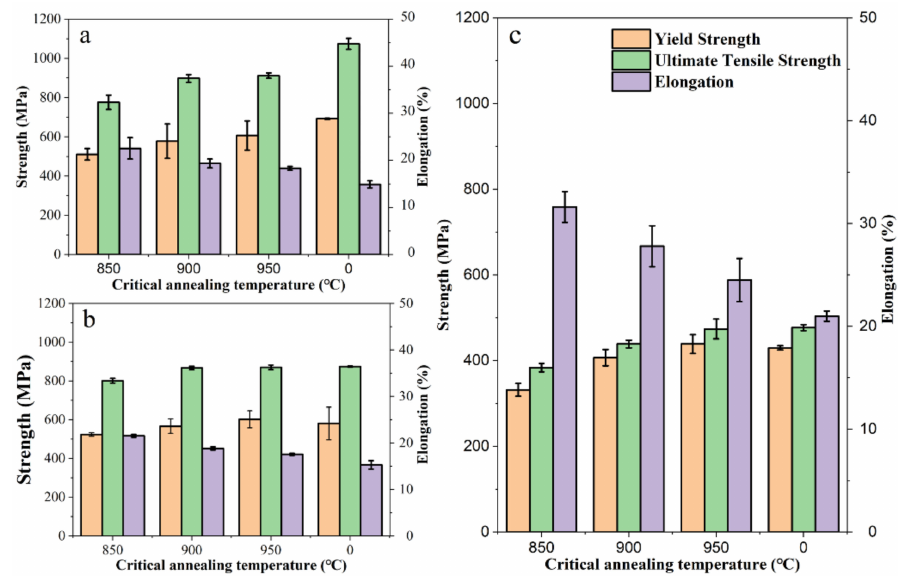
Figure 10. The mechanical properties at ( a ) room temperature; ( b ) room temperature after aging at 650 ◦ C for 128 h; and ( c ) 650 ◦